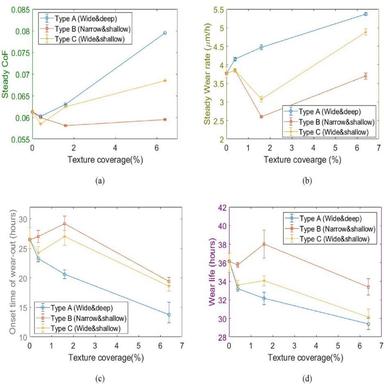
Summary of (a) Steady state frictional coefficients, (b) Steady state wear rates, (c) Onset time of wear-out stage and (d) Wear life for surfaces with different texture dimensions and coverages.